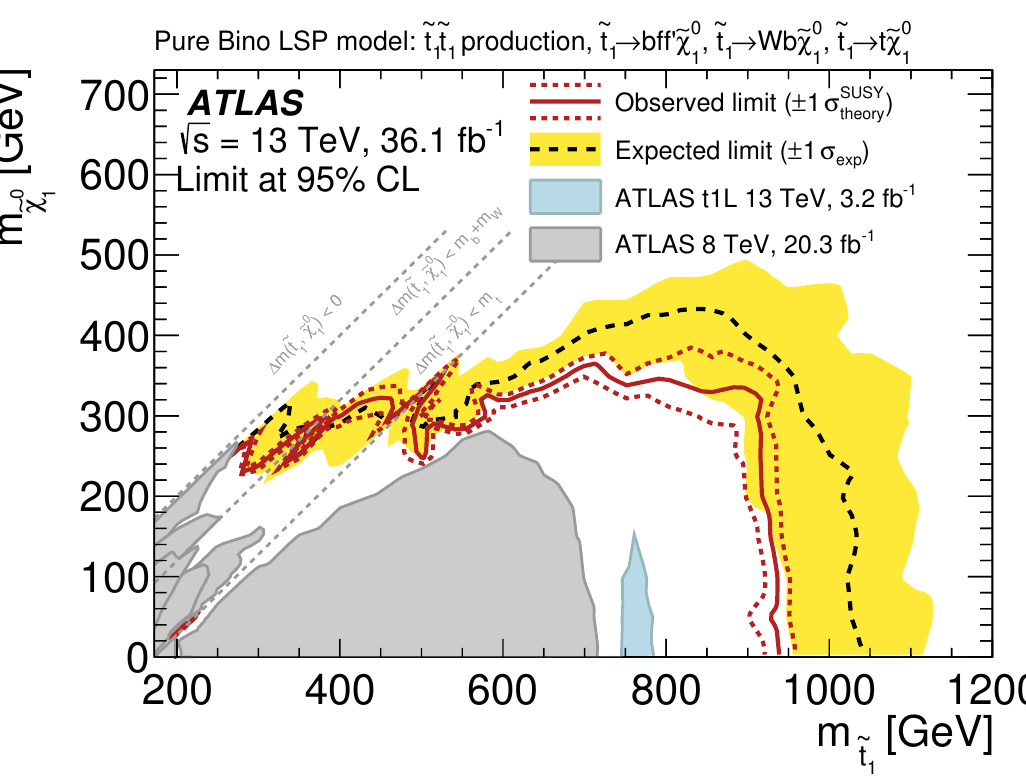
Figure 20 . Expected (black dashed) and observed (red solid) 95% excluded regions in the plane of m versus m ~ for direct stop pair production assuming either ~ t t 1 ~ (cid:31) 0 1 ~ t bff 0 ~ (cid:31) 0 1 decay with a branching ratio of 100%. The excluded regions from previous publica- 1 ! tions [37, 168] are shown with the grey and blue shaded